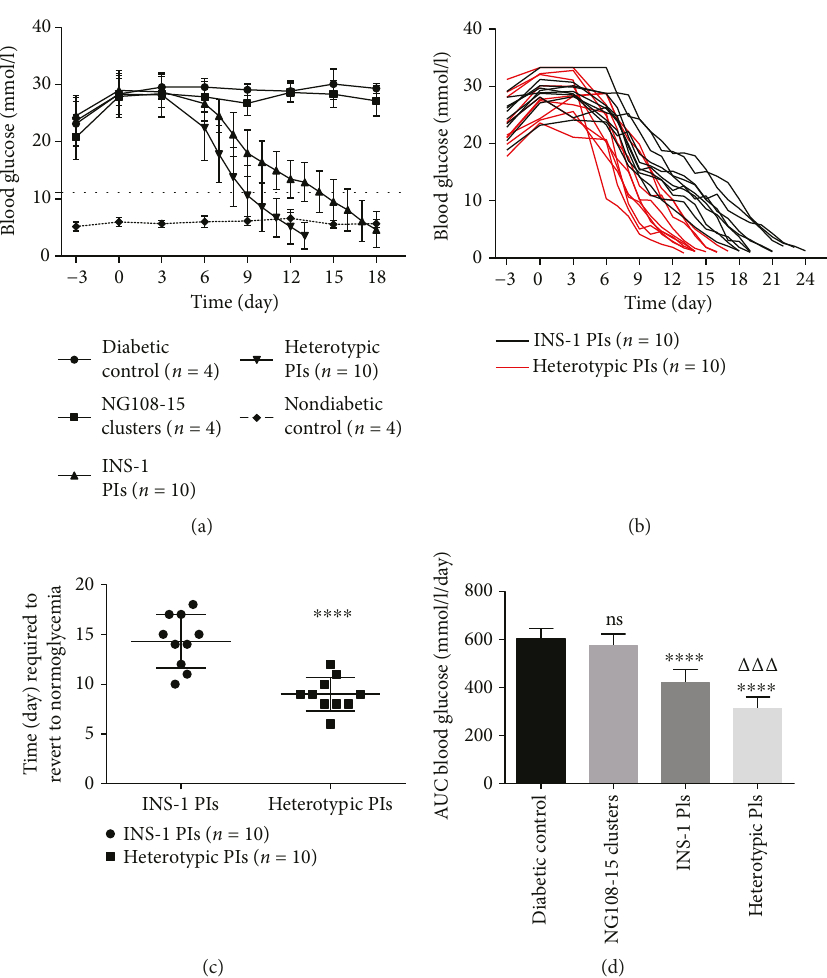
Figure 7: Subcutaneous pseudoislet transplantation regulates blood glucose levels in STZ diabetic BALB/c nu/nu mice. (a) On day 0, pseudoislets or NG108-15 clusters were injected subcutaneously into the back of nude mice. Values are mean ± SD. The dotted straight line represents 11.1mmol/l. (b) The blood glucose curves of every mice receiving PIs. The end of curves represents the death of mice. (c) Time (day) required to revert to normoglycemic ( < 11.1mmol/l) level after subcutaneous PI transplantation. ∗∗∗∗ p < 0 0001 compared to INS-1 PI group, n = 10 . (d) Areas under the blood glucose curve expressed as mmol/l/day. ns compared to diabetic control group. ∗∗∗∗ p < 0 0001 compared to diabetic control group. ΔΔΔ p < 0 001 compared to INS-1 PI